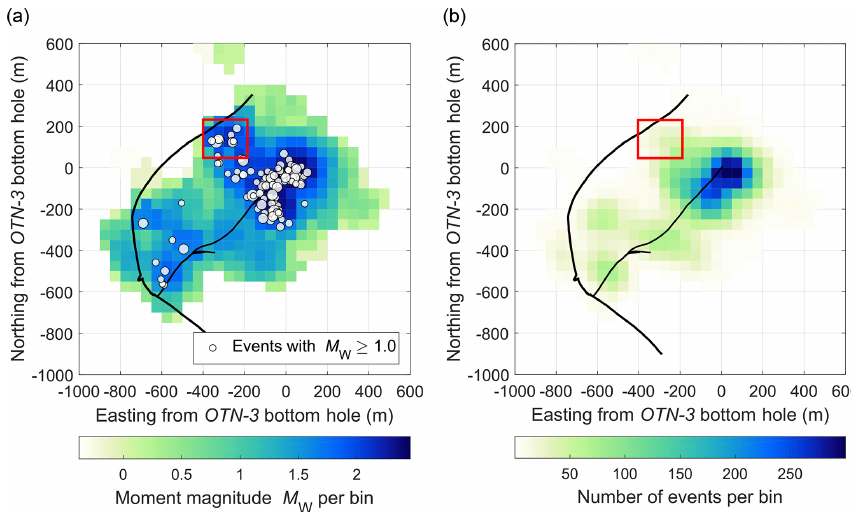
Figure 6. Spatial evolution of the cumulative seismic moment release of the relocated seismicity per bins of 50 by 50m. (a) The cumulative seismic moment release converted to seismic moment magnitude per bin overlaid by seismicity with M w ≥ 1. (b) The number of events that occurred per bin. A smaller area of anomalously high CM 0 release caused by a few large events is highlighted by red